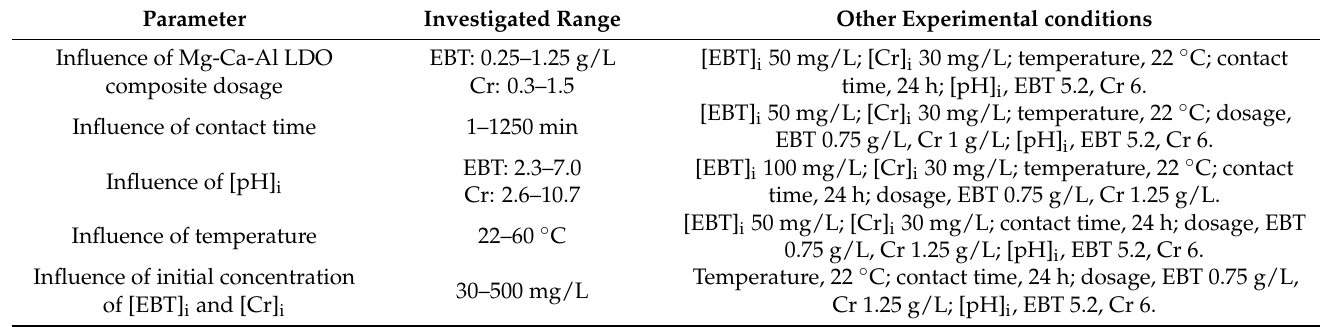
Table 7. The experimental adsorption characteristics of EBT and Cr by Mg-Ca-Al LDO composite. Parameter Investigated Range Other Experimental